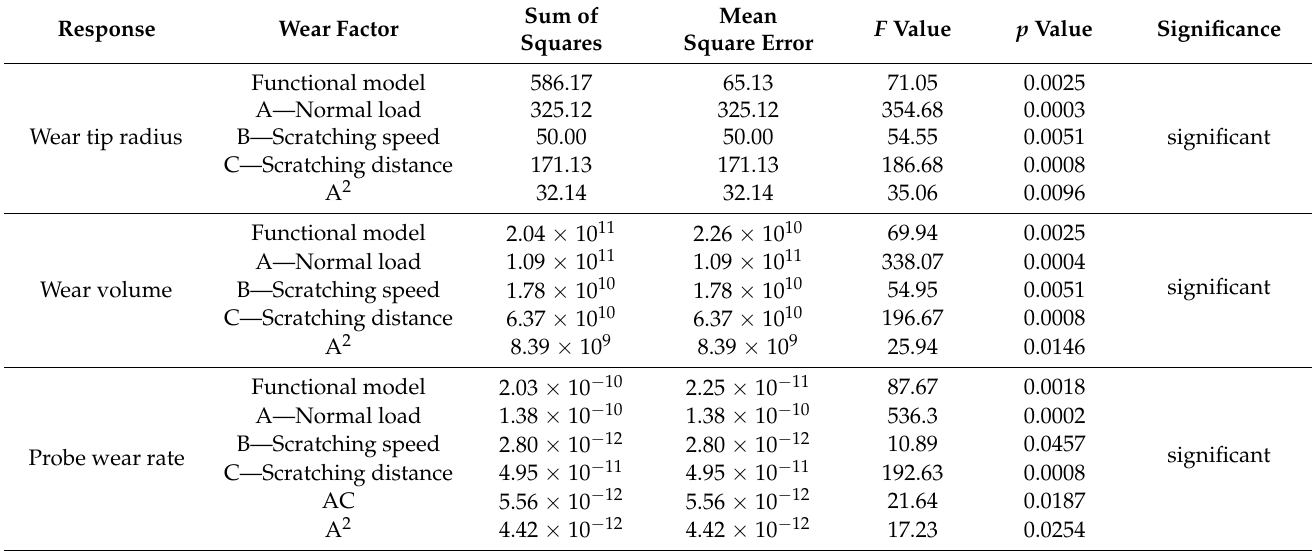
Table 4. Analysis of variance for wear factors.